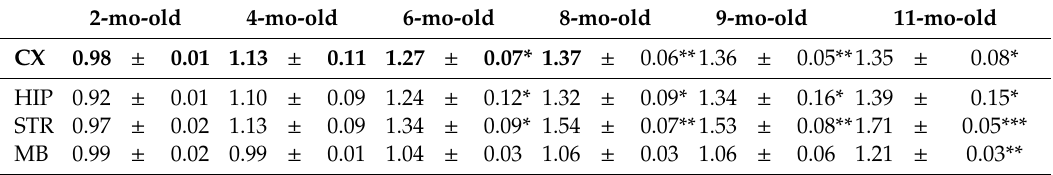
Figure 4. The scatter plots of regional 18 F-PM-PBB3 standardized uptake value ratio (SUVR) across all age groups for regions of ( A ) cortex, ( B ) hippocampus, ( C ) striatum, and ( D ) midbrain using cerebellum as the reference region. CX: cortex, HIP: hippocampus, MB: midbrain, STR: striatum, CB: cerebellum. Table 1. Quantification 18 F-PM-PBB3 standardized uptake value ratio (SUVR) values for all age